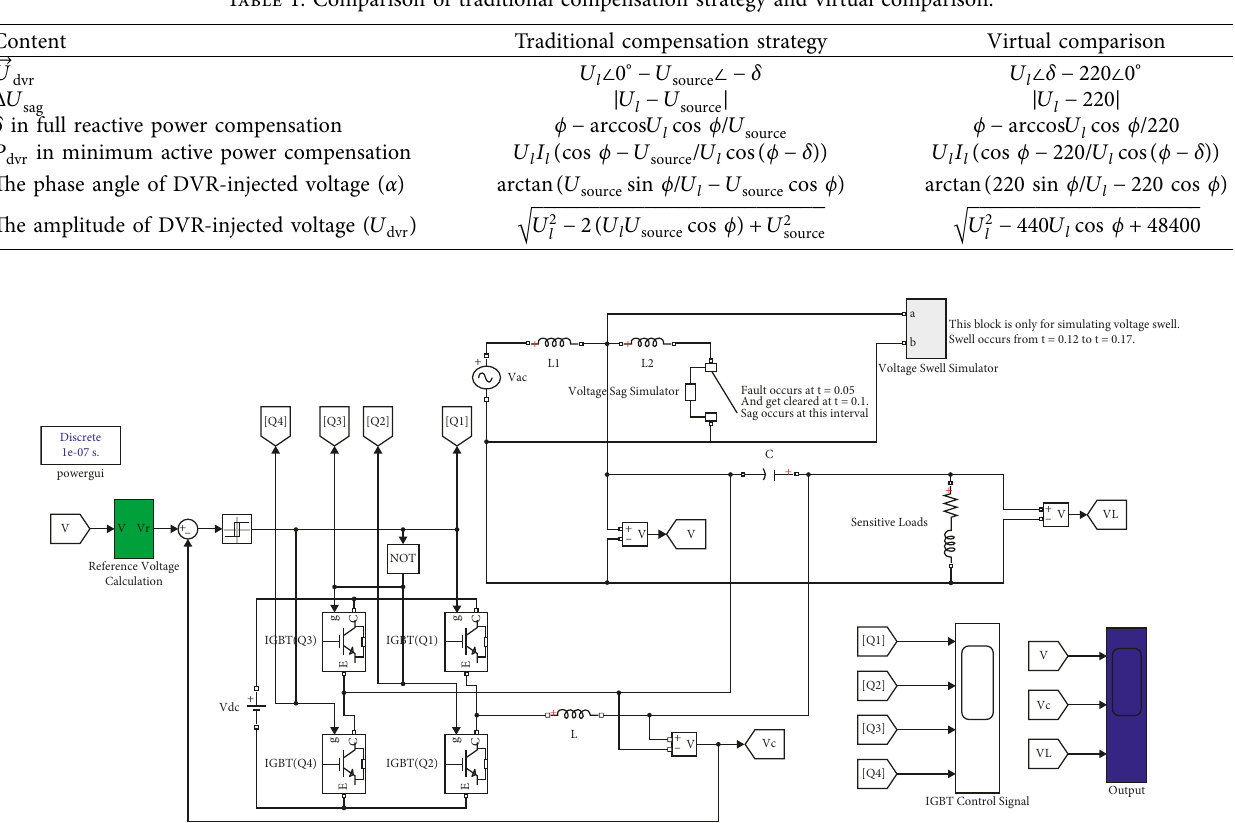
Table 1: Comparison of traditional compensation strategy and virtual comparison.